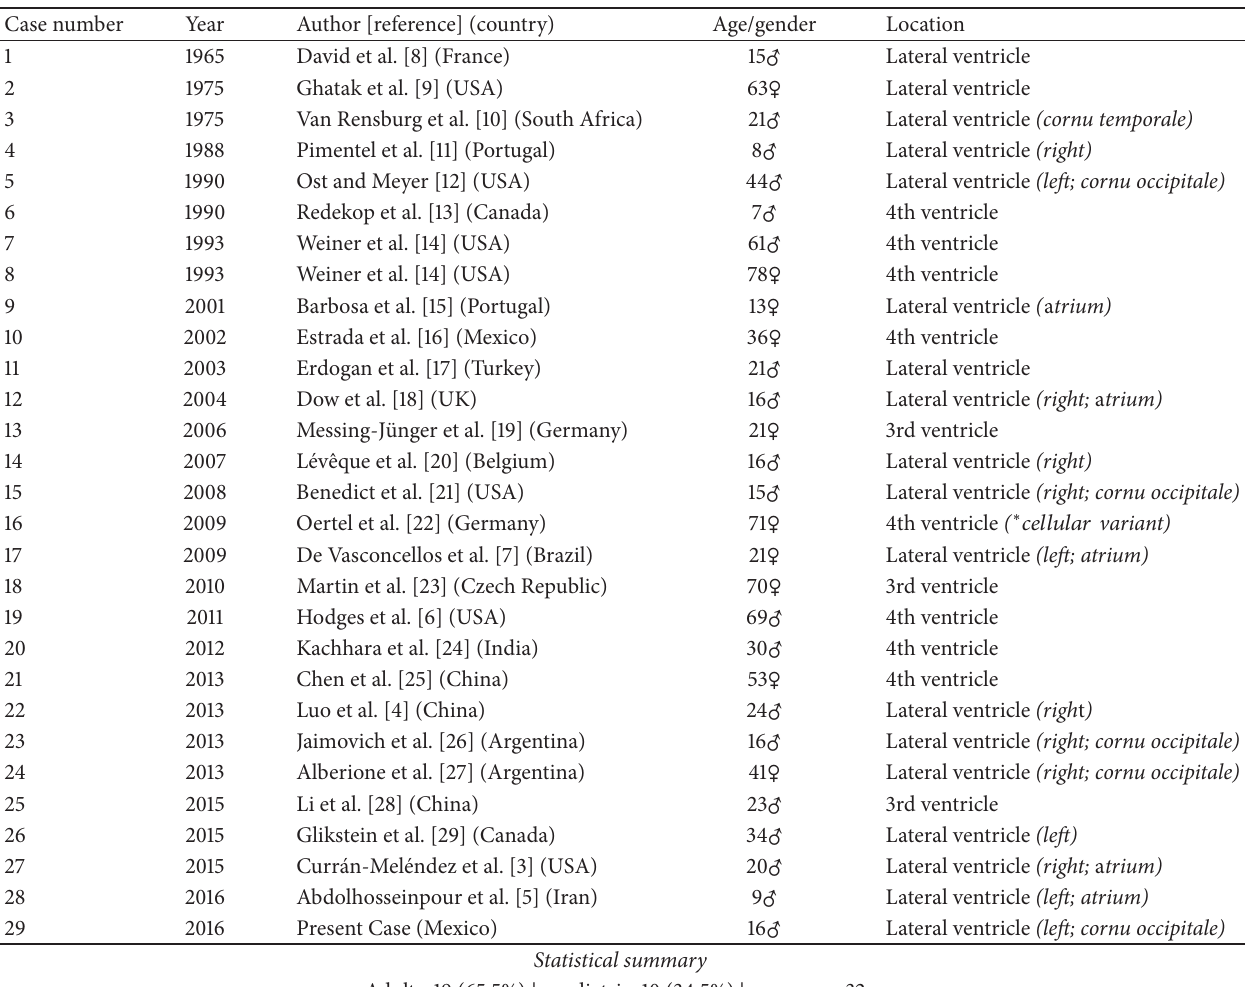
Table 1: Intraventricular neurilemmomas case